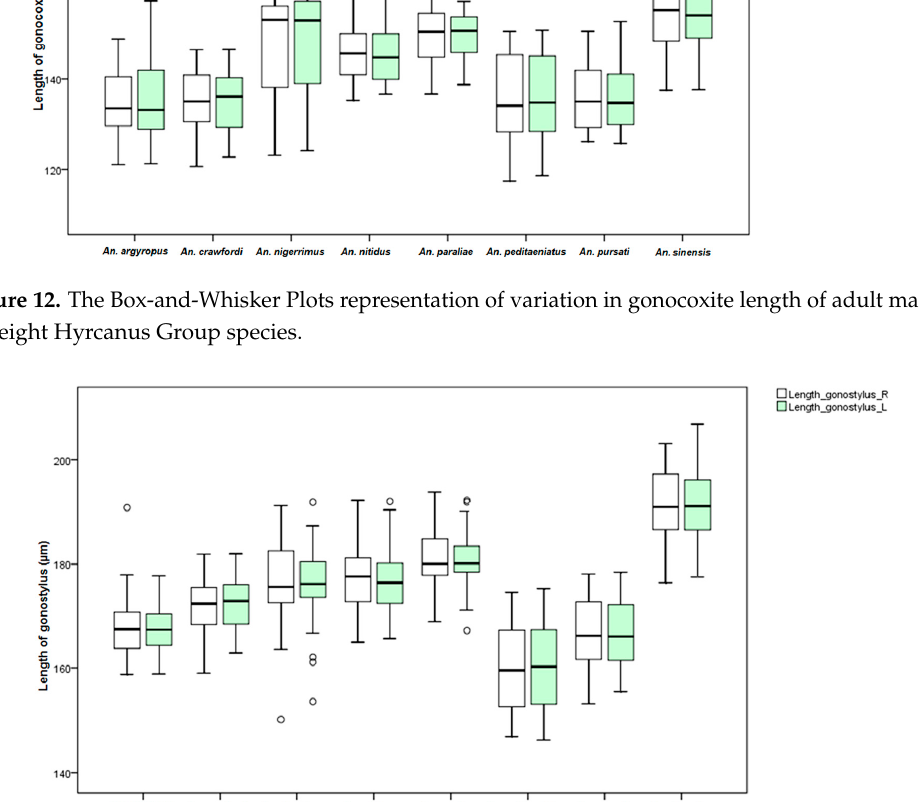
Figure 13. The Box-and-Whisker Plots representation of variation in gonostylus length of adult male of the eight Hyrcanus Group species.